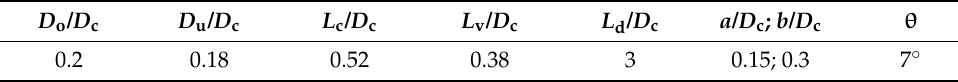
Table 3. Structural parameters of hydrocyclones for silica particle and water separation.